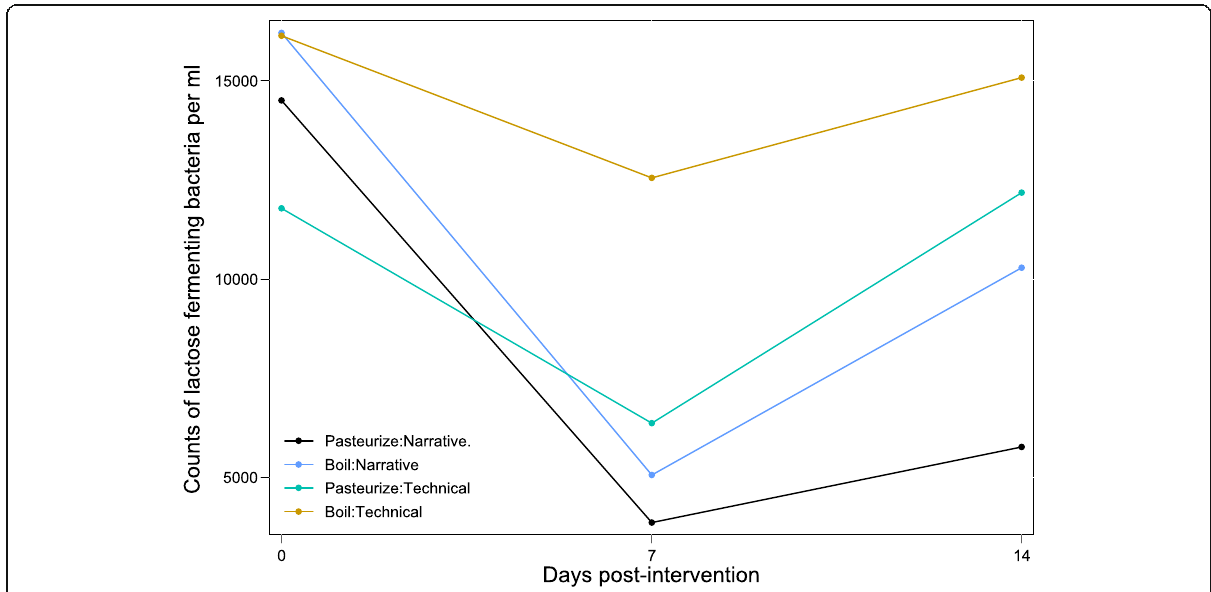
Fig. 5 Total bacterial counts in milk and containers across intervention strategies. See text for significant differences between